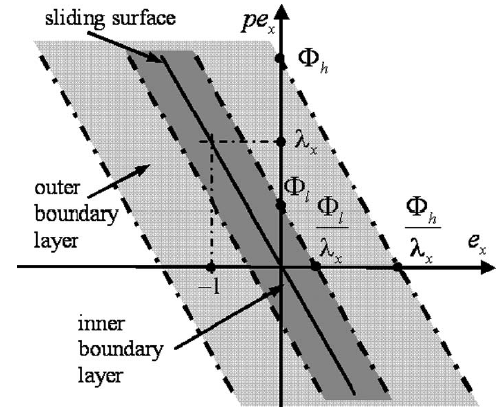
Figure 5. Sliding surface and the boundary layers in the state plane. Reprinted with permission from Ref. [26]. Copyright 2009